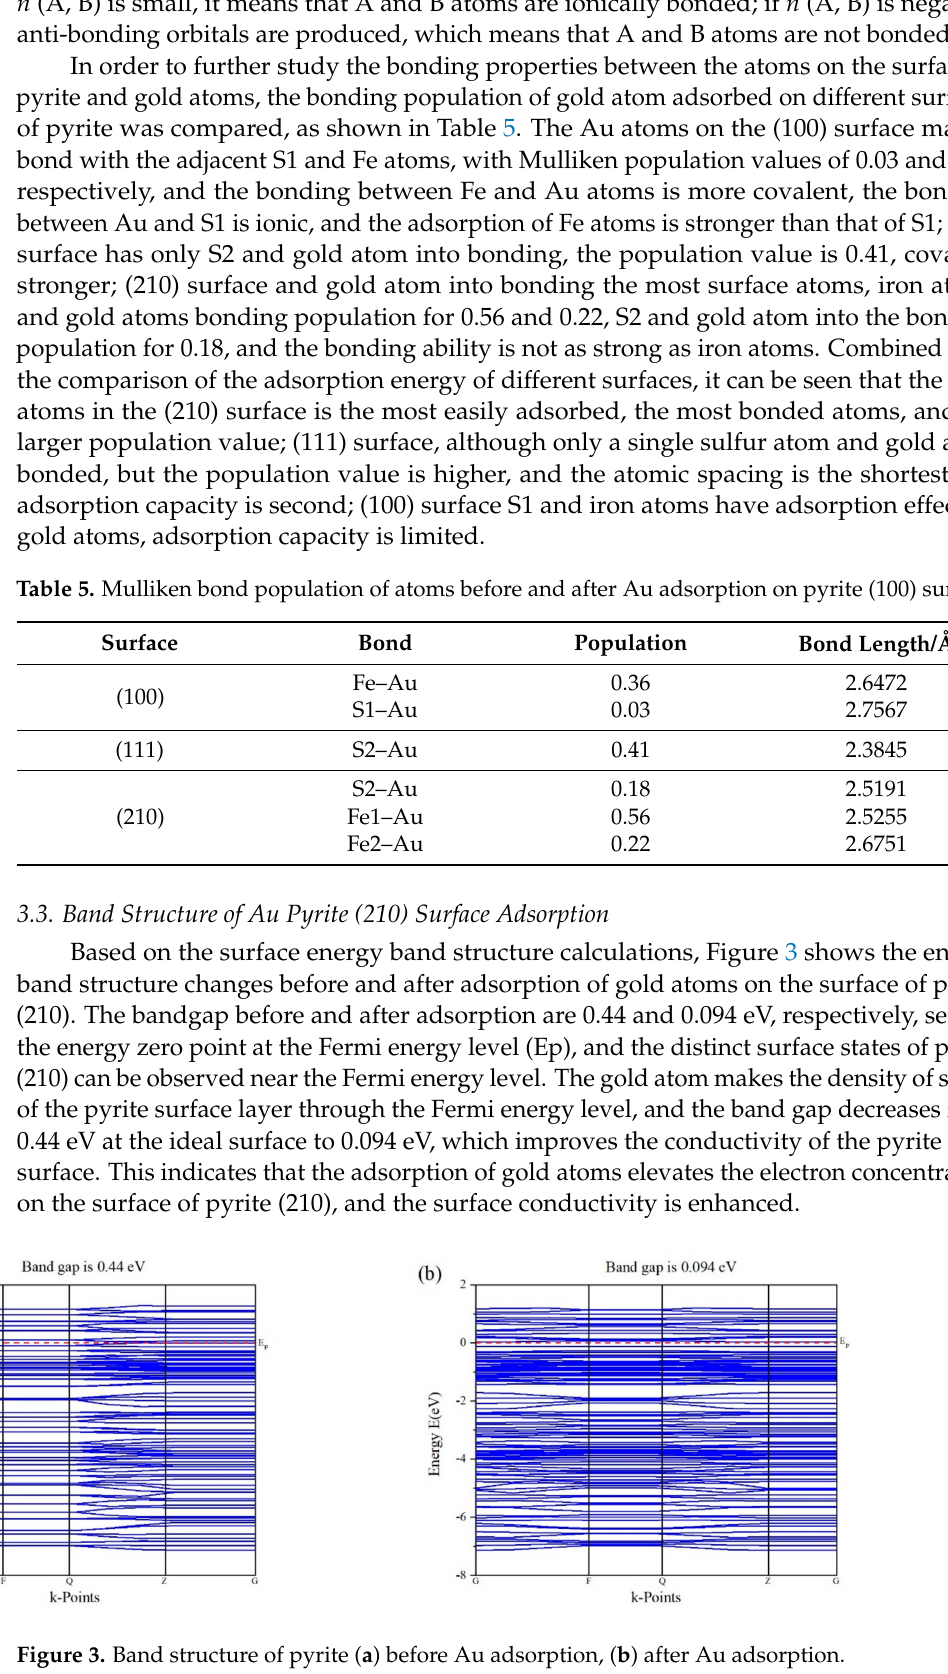
Figure 3. Band structure of pyrite ( a ) before Au adsorption, ( b ) after Au